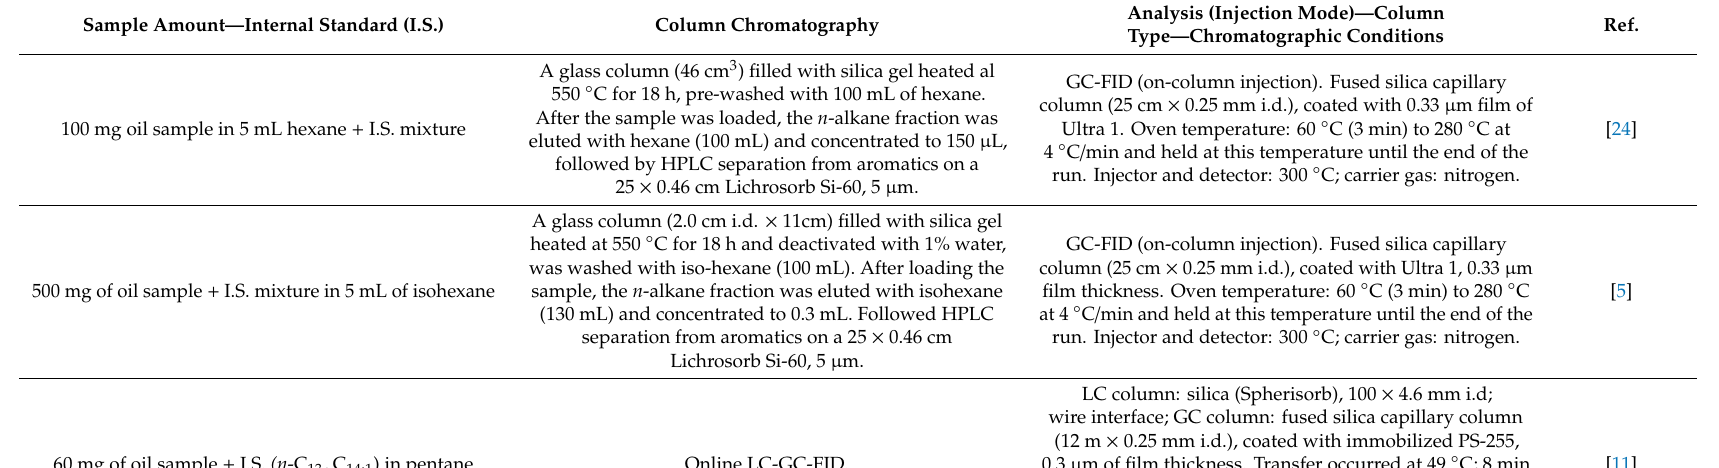
Table 4. Methods based on use of fat retainers for n-alkane determination in vegetable oils. Sample Amount—Internal Standard